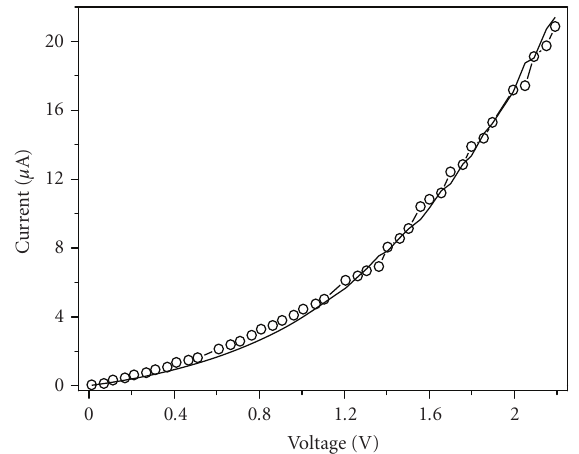
Figure 5: Experimental I-V characteristics of ITO/PANI-co- POT/Al device ( ◦ ) and fit (line) using (2) and (3).